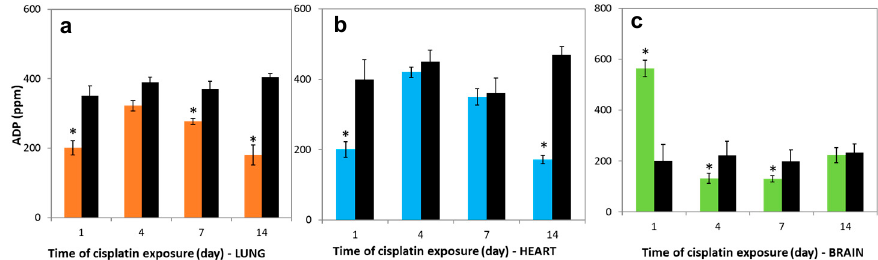
Figure 6. ADP levels in ( a ) lung, ( b ) heart, and ( c ) brain tissues over time. Lung ( ⎯ ⎯ ), heart ( ⎯ ⎯ ), and brain ( ⎯ ⎯ ) tissues of treatment group, and controls ( ⎯ ⎯ ). Results are expressed as mean ± SD ( n = 6). *Significantly different ( p < 0.05) from control.